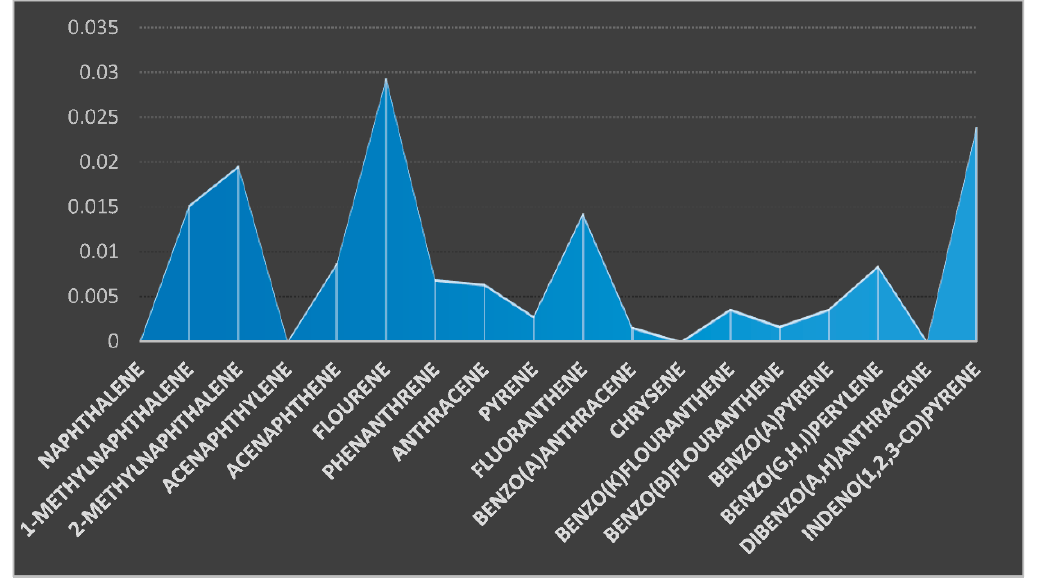
Figure 5. Concentration of PAHs components (µg/kg) in the sediment sample from location